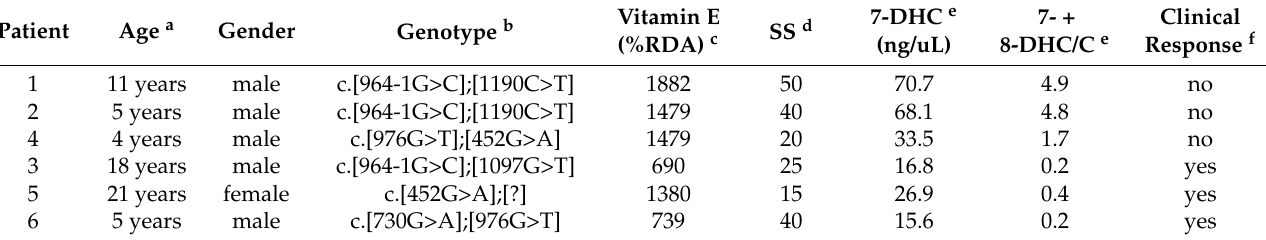
Table 2. Summary of requirement and clinical effectiveness of vitamin E in relation to plasma 7-DHC + 8-DHC/cholesterol